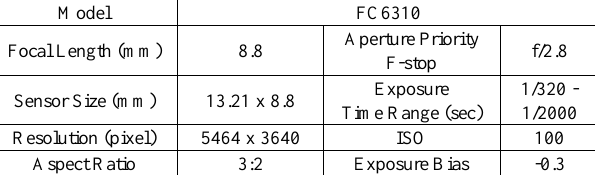
Table 1. Camera specifications for DJI Phantom 4 Pro Camera (Model FC6310) and capture